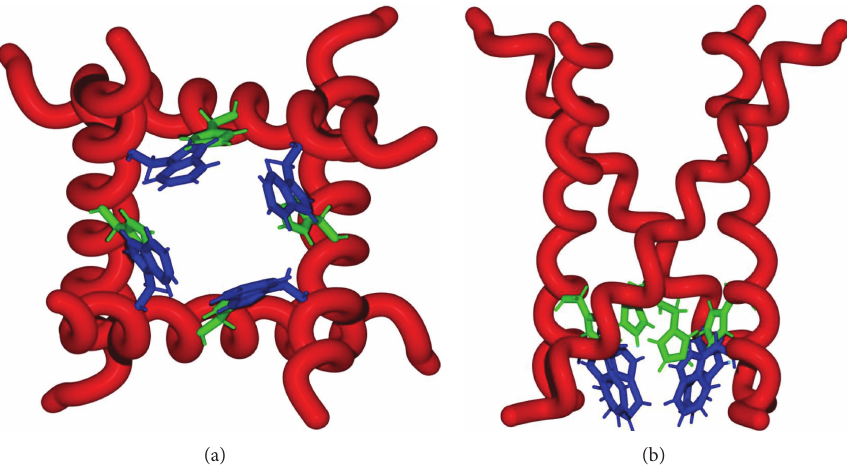
Figure 4: Transmembrane part of the M2 proton channel; illustrated are the His-37 (green) and Trp-41 (blue) interactions that control the gating mechanism of the four helices in a bundle. The conformations of the Nishimura model at pH 8 of His-37 ( 𝜒 1 , 𝜒 2 ) = ( − 177 ∘ , +172 ∘ ) and Trp-41 ( 𝜒 1 , 𝜒 2 ) = ( − 177 ∘ , − 105 ∘ ) are used (PDB-code: 1NYJ). The His-37 and Trp-41 conformations in this model cause strong Van der Waals contacts. (a) Bottom view. (b) Side view.